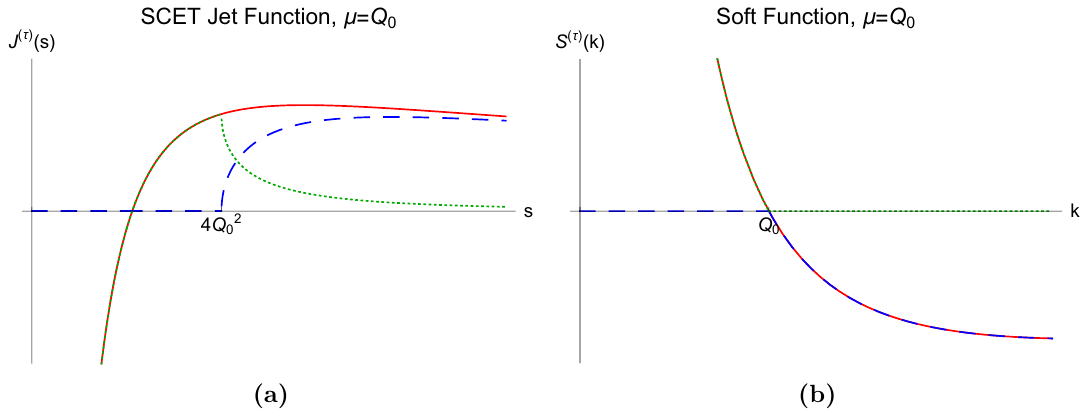
Figure 5. SCET jet function for massless quarks (a) and soft function (b) without cut (solid red), unreleased (dotted green) and with cut (dashed blue) for (cid:22) = Q 0